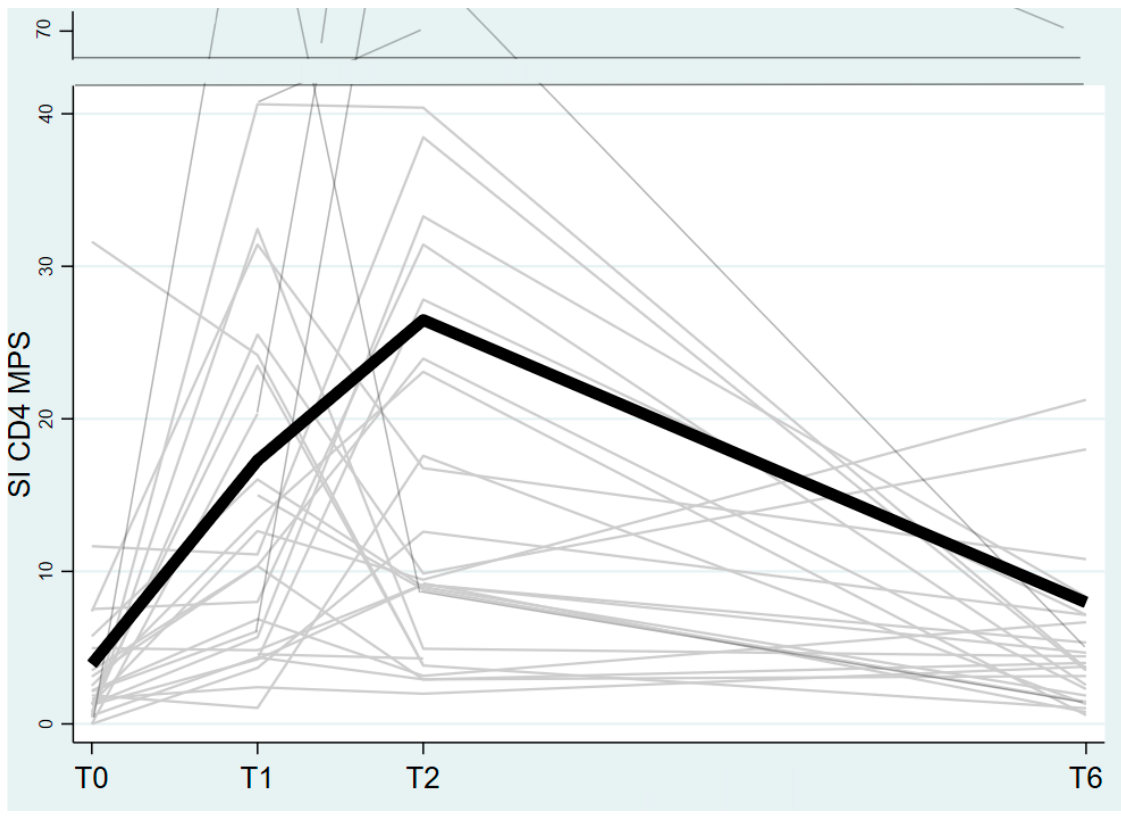
5 of 15 Table 1. Clinical characteristics of subjects enrolled in the study ( overall population, group A and group B ) . The Mann–Whitney test was performed for age and the Chi-squared test or the Fisher’s exact test was performed for the categorical variables. SD: standard deviation. * Comorbidities: Hypertension, under therapy. Overall N = 29